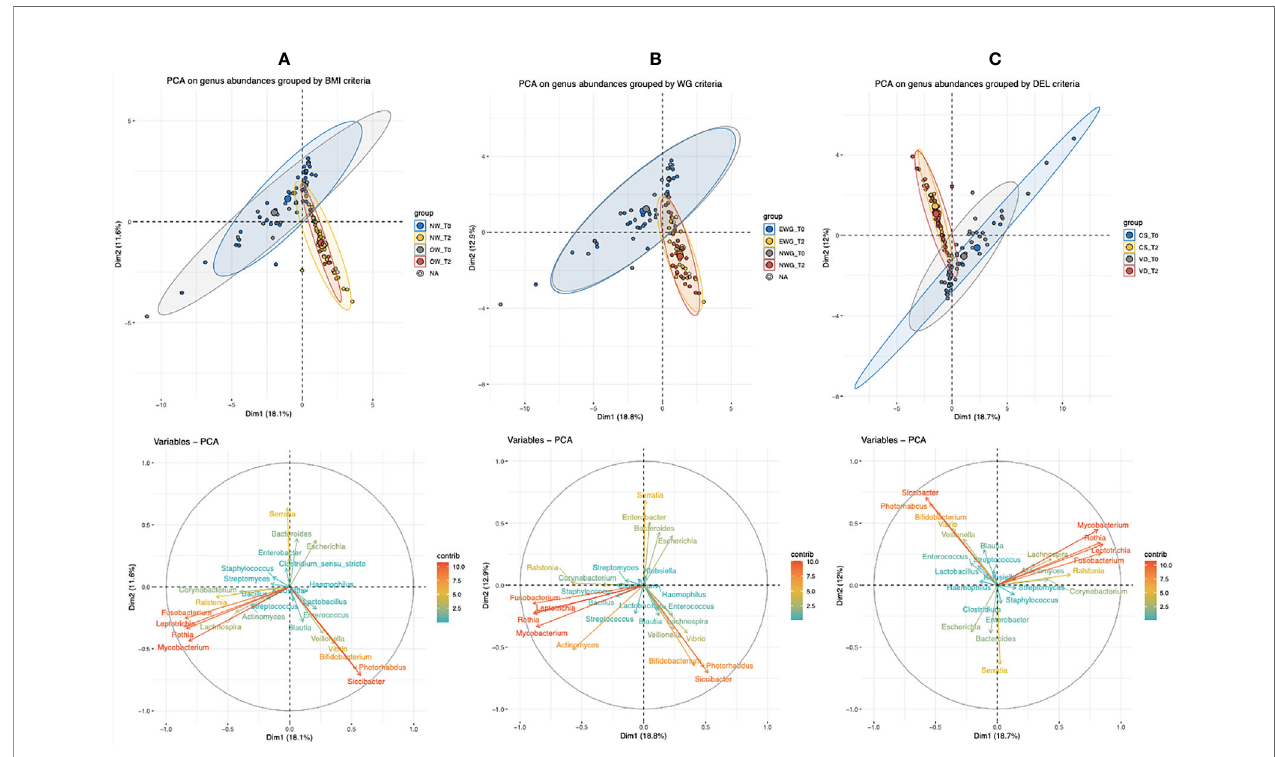
FIGURE 5 | Principal component analysis (PCA) of bacterial genera with a median abundance >0.1% (16S rRNA gene amplicon sequencing) of infants ’ T0 (meconium) and T2 (six months of age). Infants were grouped based on the relative metadata: (A) maternal pre-pregnancy BMI (NW, normal BMI, or OW, mothers with overweight/obesity), (B) maternal gestational weight gain (NWG, normal WG, or EWG, excessive WG), and (C) type of delivery (VD, vaginally delivered, or CS, by caesarean